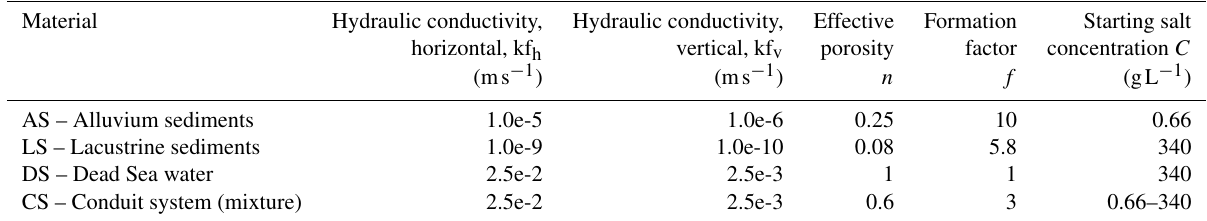
Table 2. Hydrogeological model material parameters.